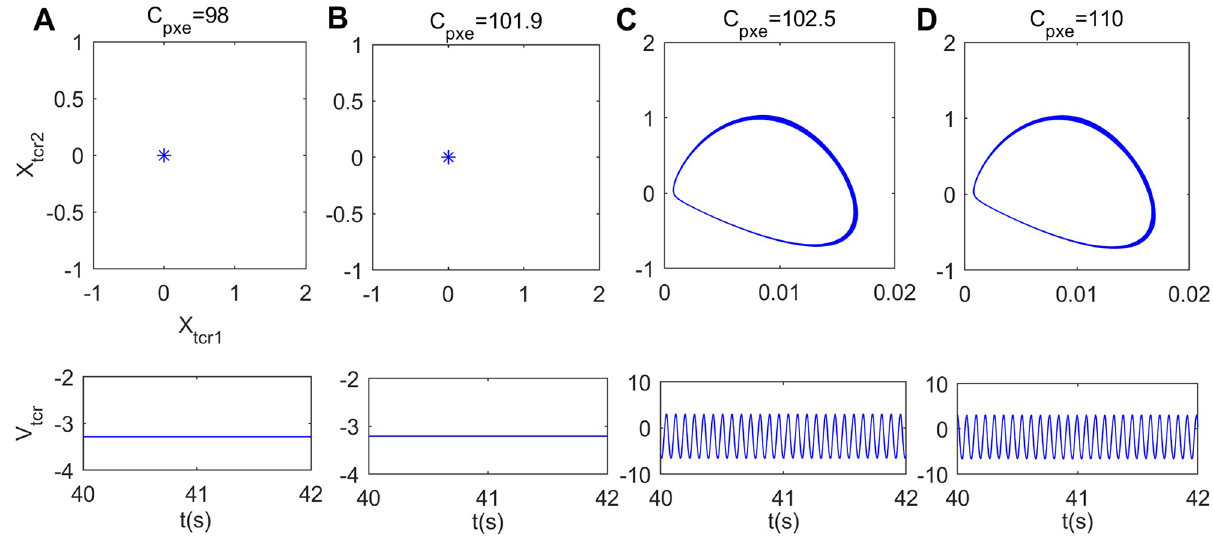
Fig 11. Phase plots (top panels) and the corresponding time series plots (bottom panels) of the thalamic module when C (A) C pxe = 98, (B) C pxe = 101.9, (C) C pxe = 102.5, (D) C pxe = 110.